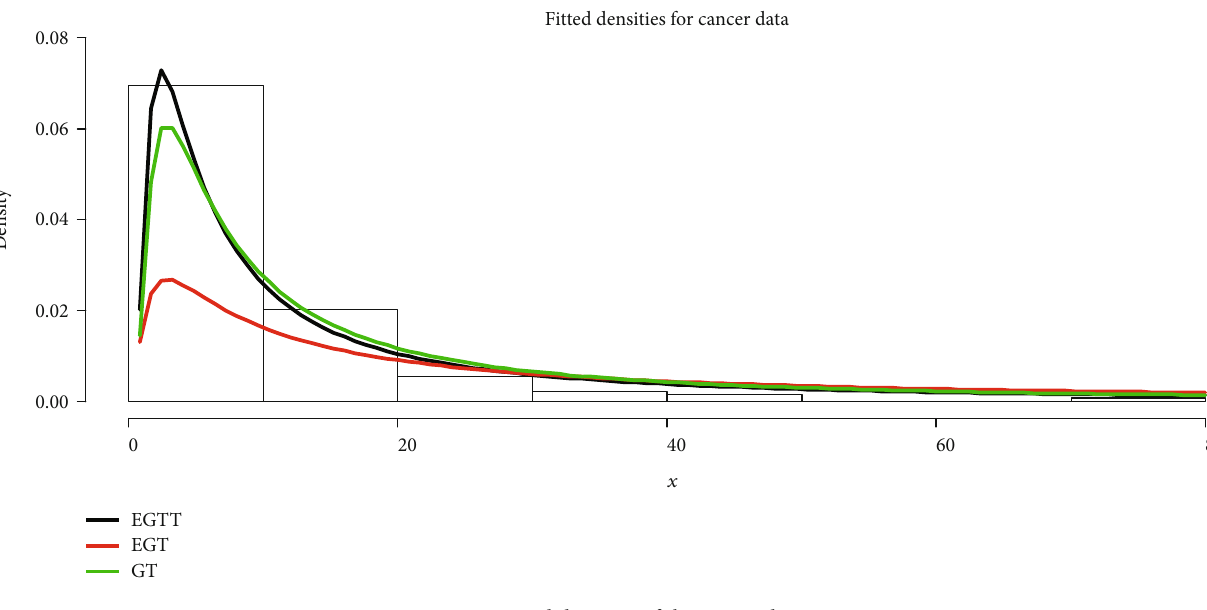
Figure 8: Fitted densities of the cancer